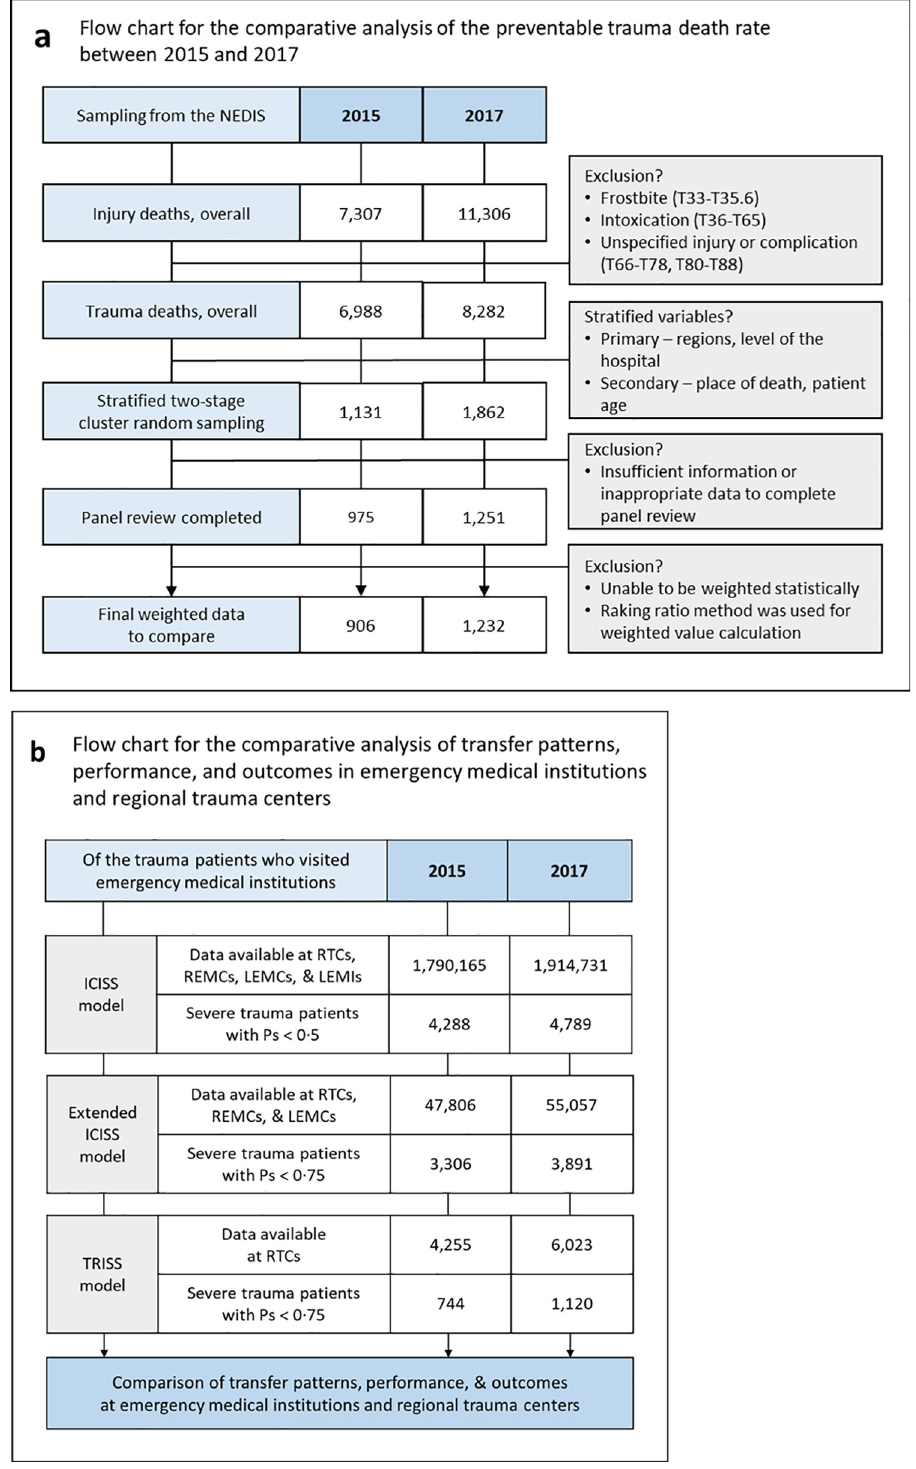
Fig 2. A flow chart of the study design. (a) is a flow chart for the comparative analysis of the preventable trauma death rate via a multi-panel review; (b) is a flow chart for the analysis of the changes in performance, including the transfer patterns of trauma patients and the outcomes of trauma care in the emergency medical system in South Korea. RTC, Regional Trauma Center; REMC, Regional Emergency Medical Center; LEMC, Local Emergency Medical